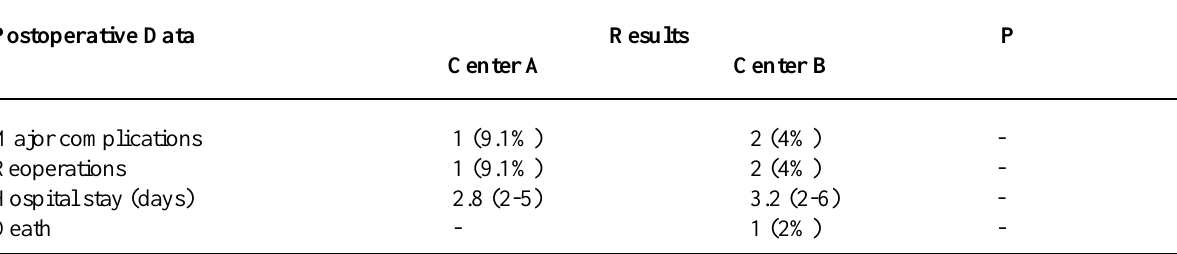
Table 2 – Postoperative data of